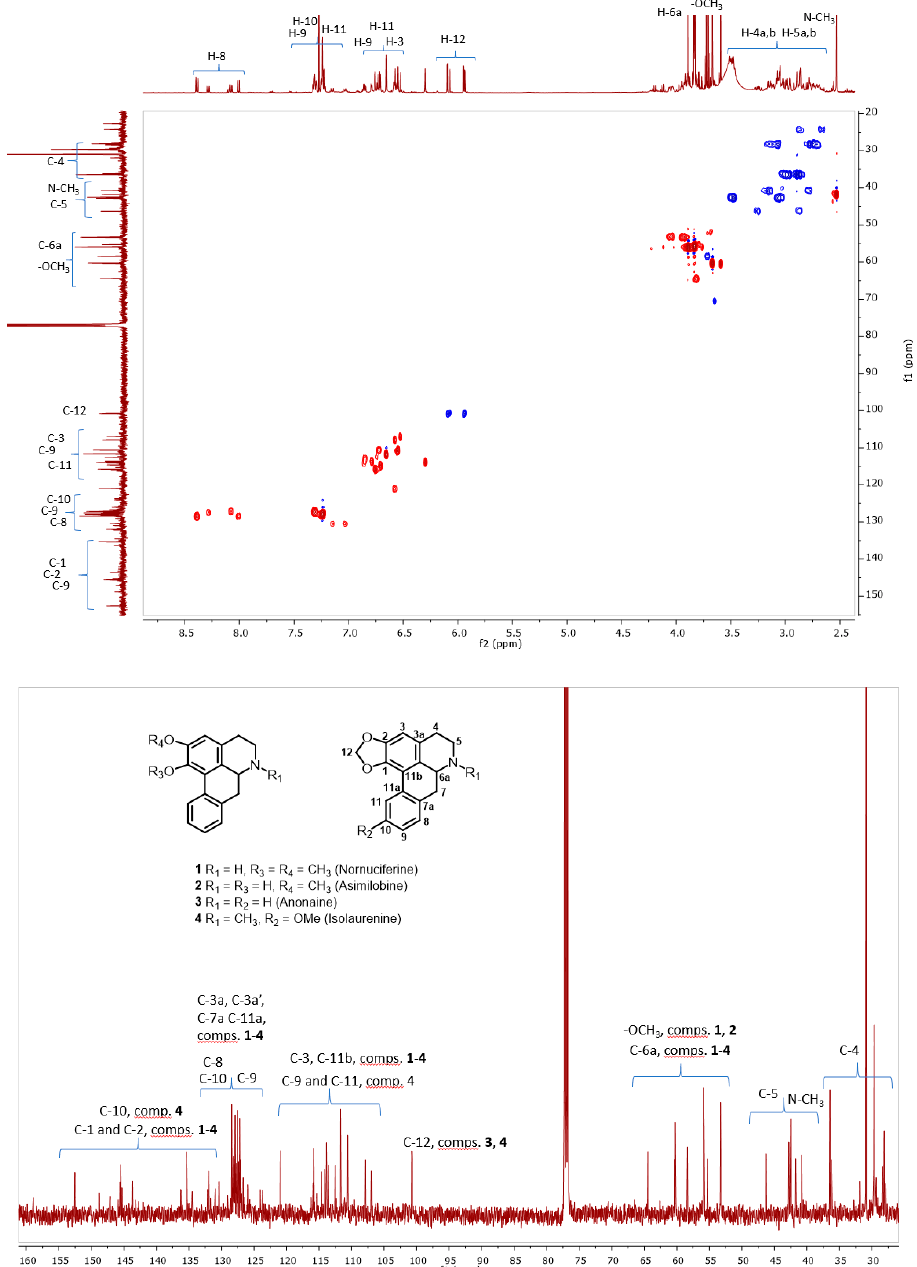
Figure 4. Heteronuclear single quantum correlation ( HSQC, top ) and 13 C nuclear magnetic resonance (NMR) spectrum ( bottom ) of the alkaloid-enriched F105-150 fractions obtained from the chromatography of the selective extract of alkaloids from A . muricata peel. HSQC experiment shows one-bond correlations for all protonated carbons and help discriminate all non-protonated carbons. 13 C NMR spectra ( bottom ) shows the range of chemical shifts in which the different types of carbons belonging to alkaloids nornuciferine 1, assimilobine 2, anonaine 3, and isolaureline 4 appear. Bold numbers identify the signals corresponding to each alkaloid according to its identification number.